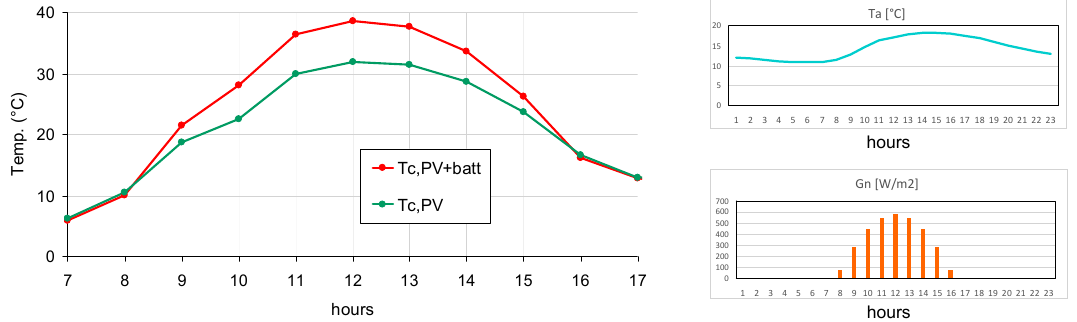
Figure 11. Average PV cells temperature profile over the day (April 15) with and without integrated storage batteries, and corresponding air temperature ( T a ) and sun irradiance ( G n ).